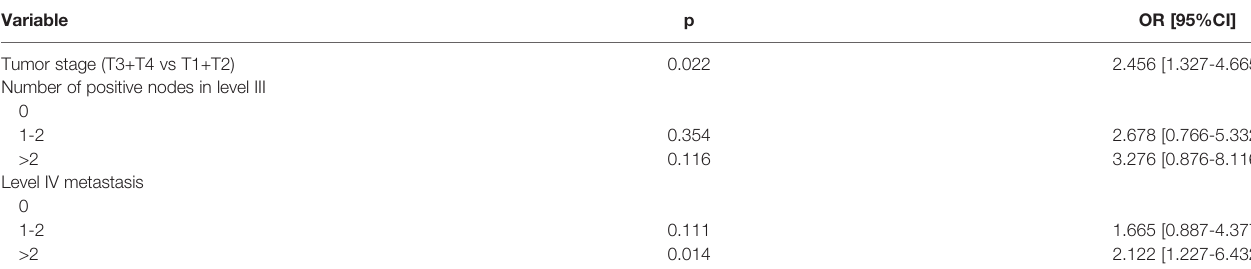
TABLE 2 | Multivariate analysis of the predictors for lymph node between sternocleidomastoid and sternohyoid muscle (LNSS) metastasis. Variable p Tumor stage (T3+T4 vs T1+T2)